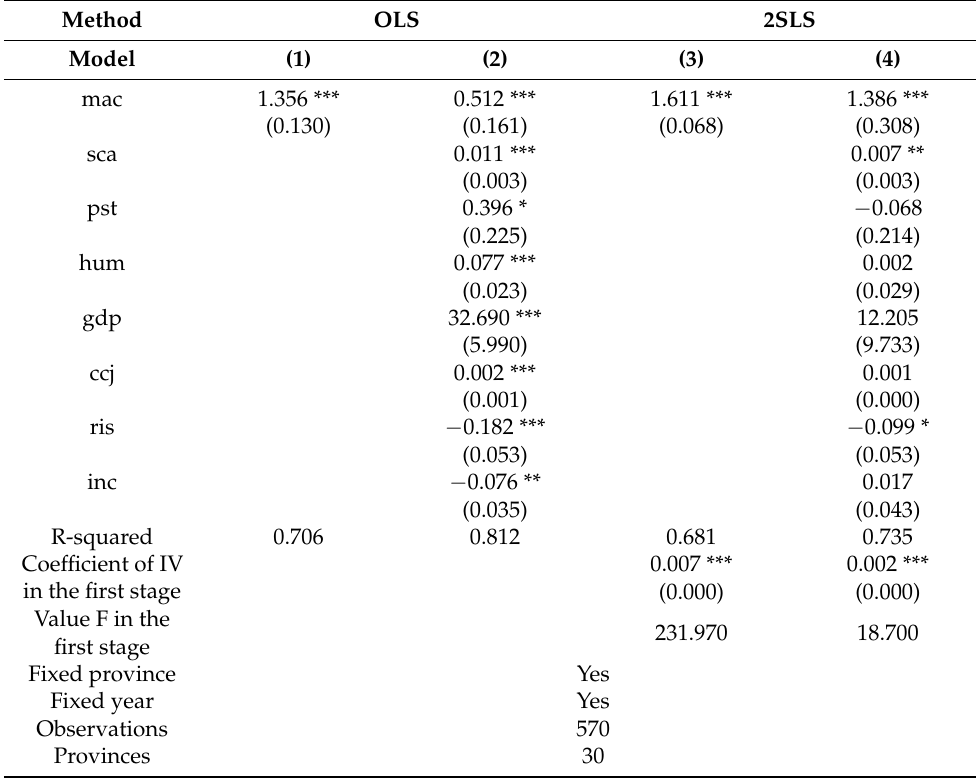
Table 2. Results of the relation between mechanization and planting